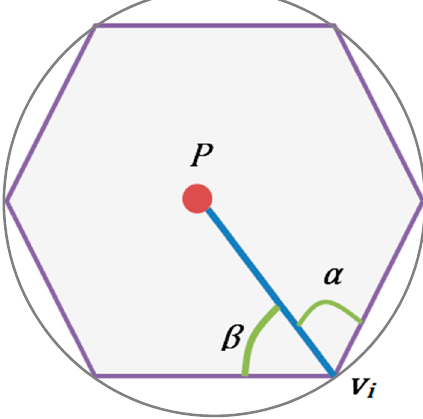
Figure 2. Generalized barycentric coordinate interpolation.